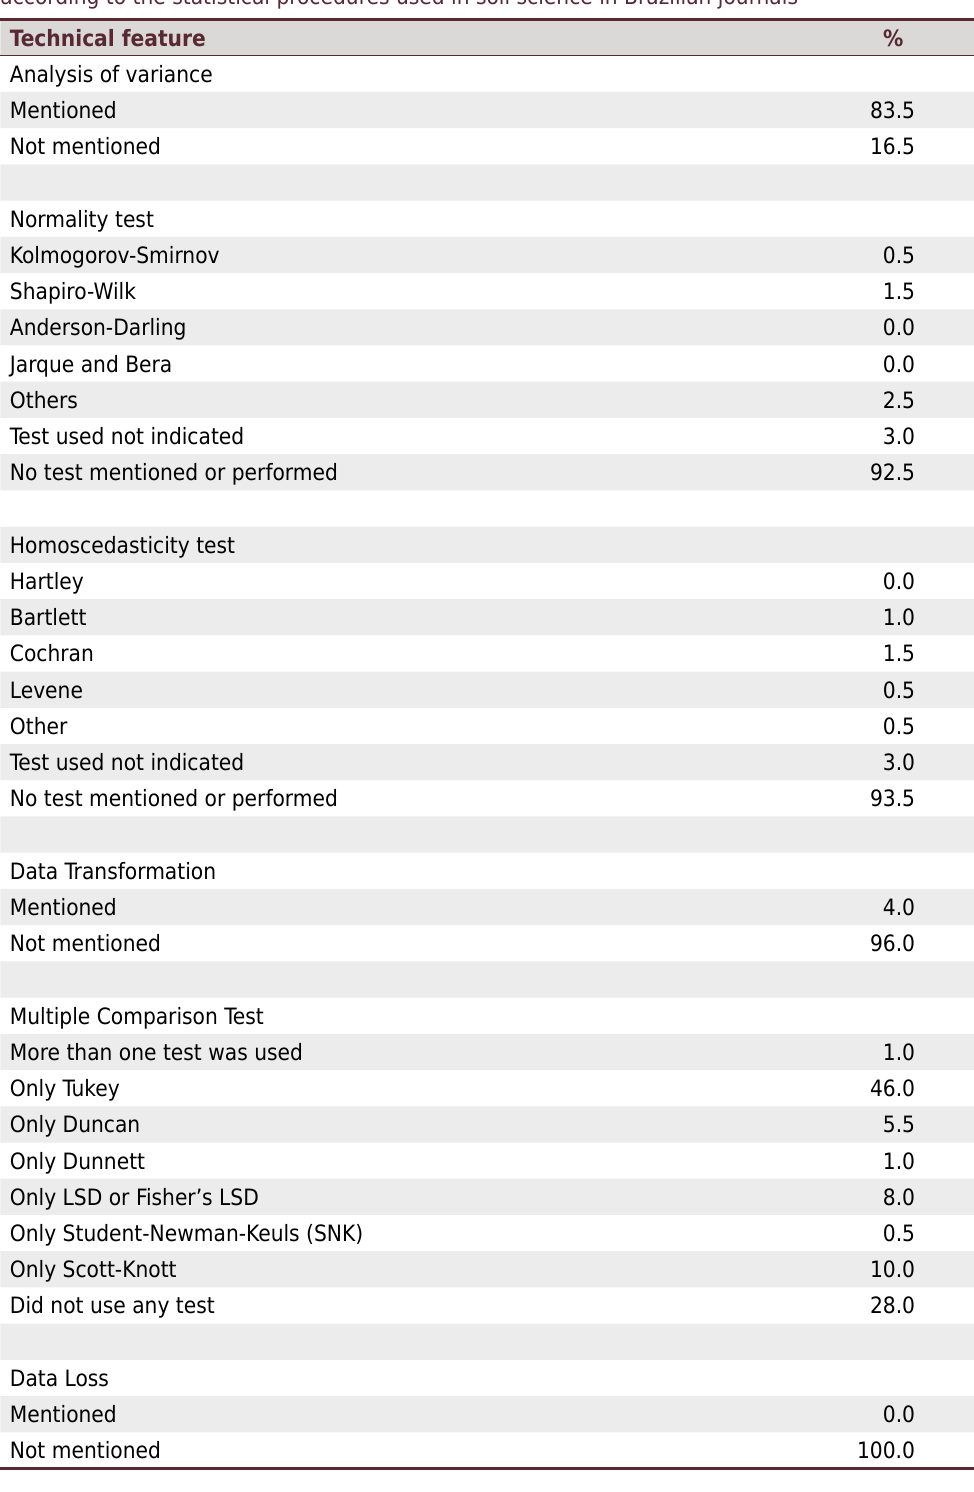
Table 3. Frequency of studies, in percentages of the total number of studies assessed, classified according to the statistical procedures used in soil science in Brazilian journals Technical